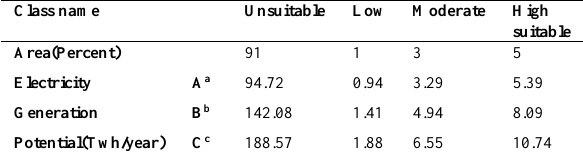
Table8. Solar electricity potential by using PV system with different module efficiencies in different levels. Class name